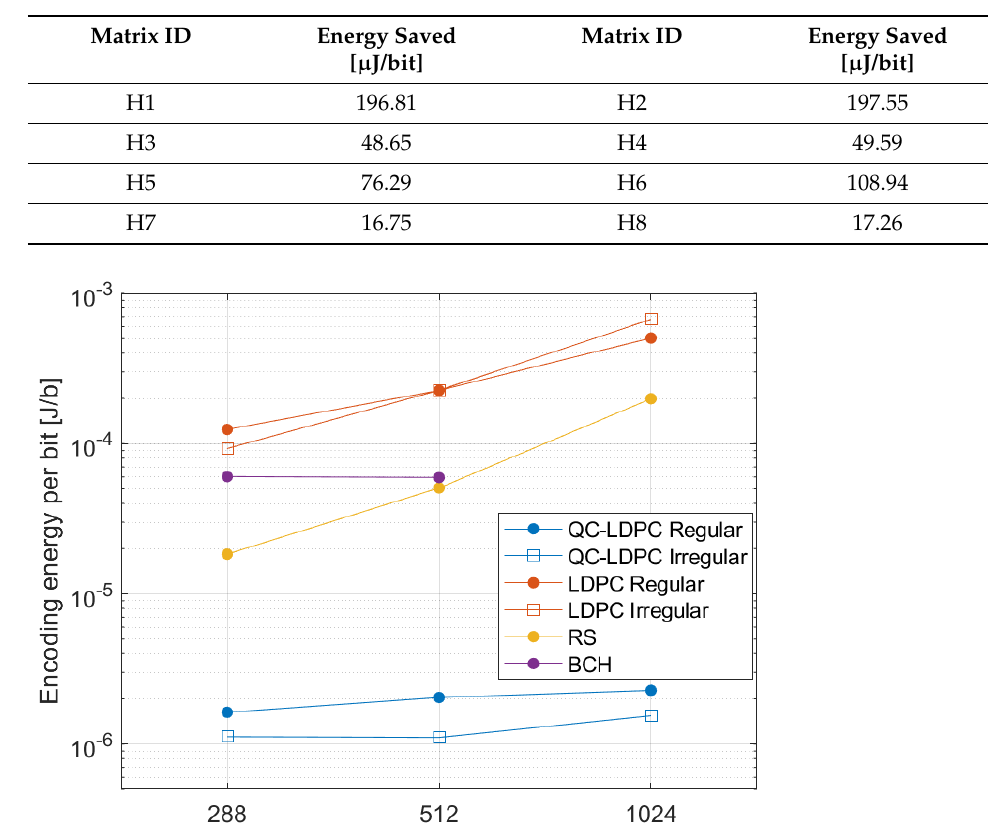
Table 3. Energy savings per bit, achieved for QC-LDPC encoding, in comparison with counterpart Reed–Solomon encoding.